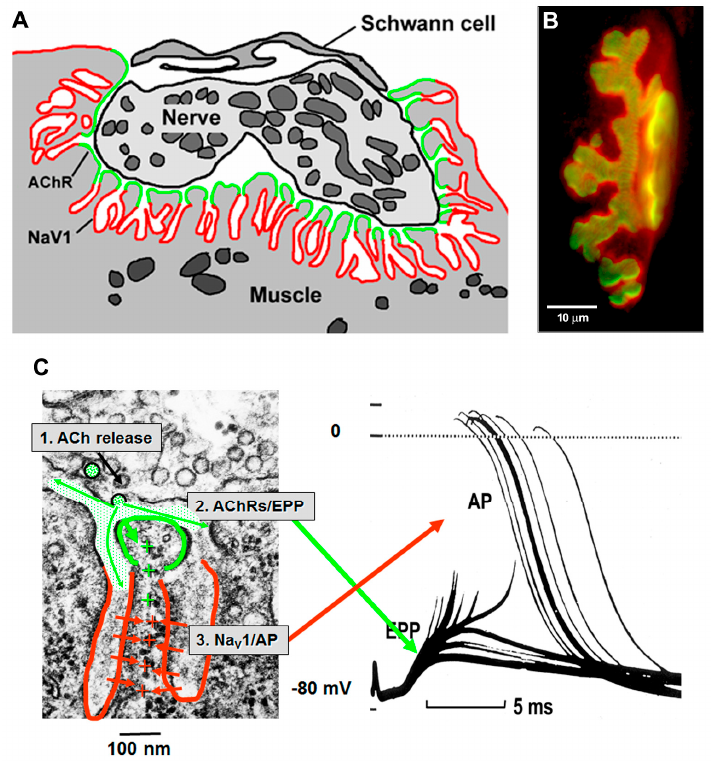
Figure 4. Postsynaptic folds and the anatomy of mAP generation. ( A ) Diagram of ion channel distribution at a rat NMJ. AChRs (green) are concentrated at the crests of the folds, while Na V 1.4 channels are concentrated in the depths of the folds; ( B ) Fluorescence of rat NMJ showing AChRs (green) and Na V 1.4 channels (red). Note that the Na V 1.4 labeling protrudes beyond the AChRs because